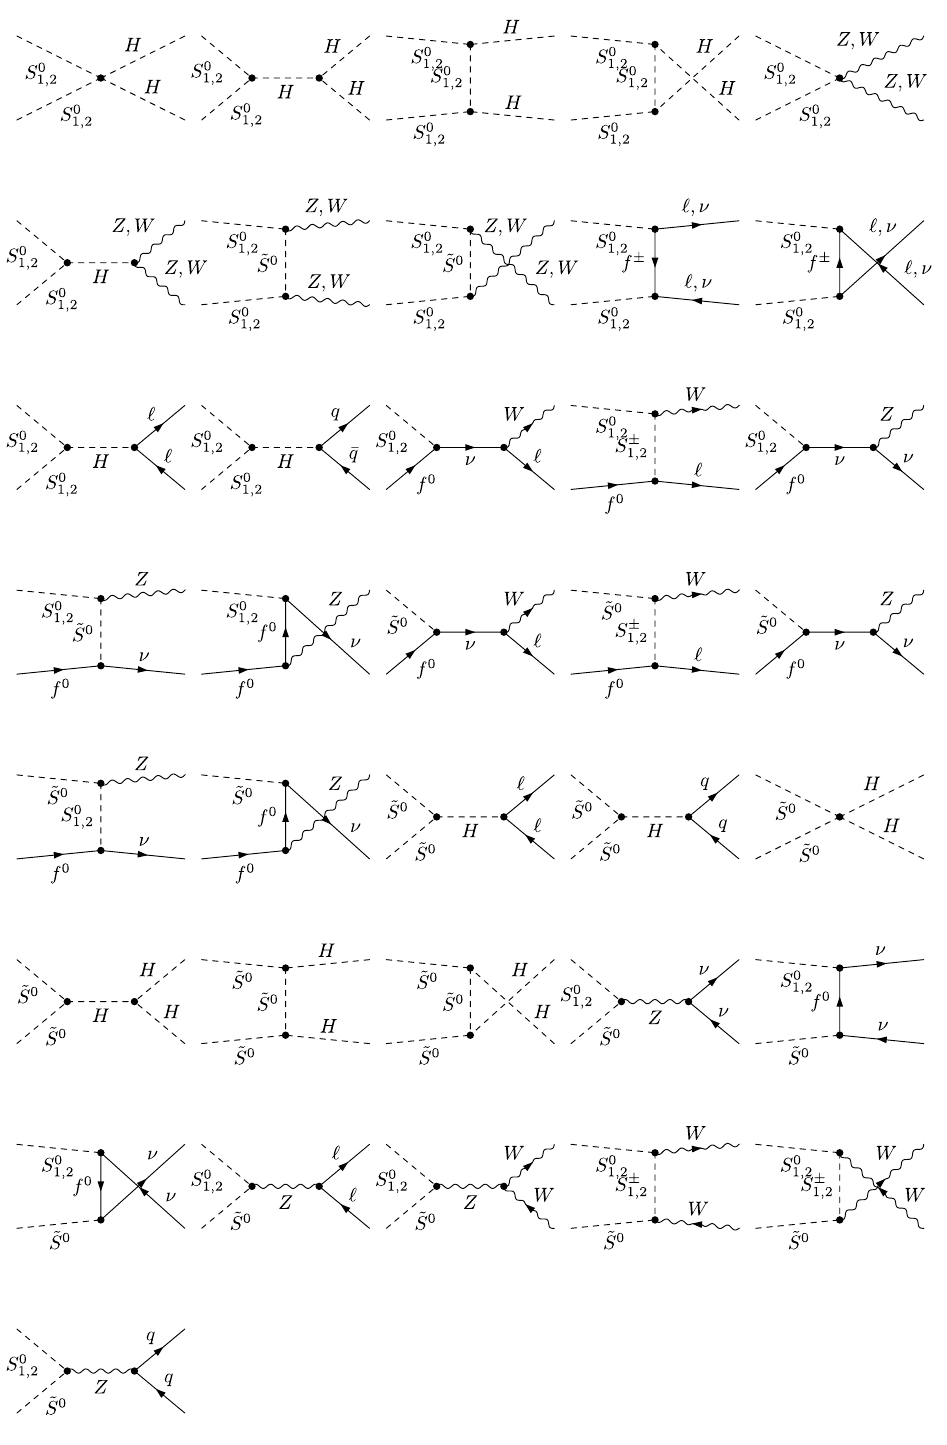
Figure 12 . Diagrams relevant for the DM production involving neutral initial states ( Q = 0